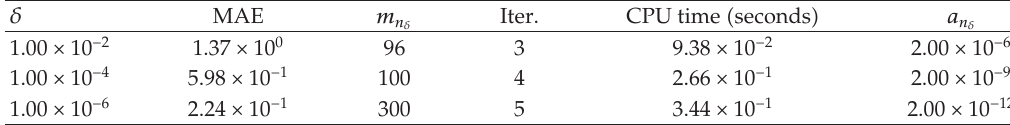
Table 12: Example